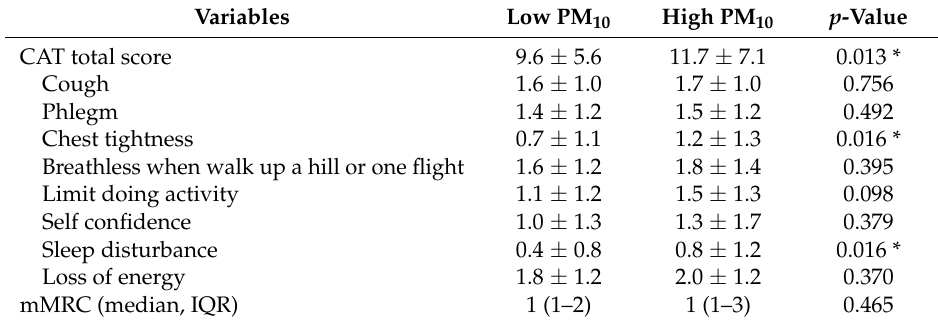
Table 3. Quality of life and dyspnea in the period of high PM 10 versus the period of low PM 10 .